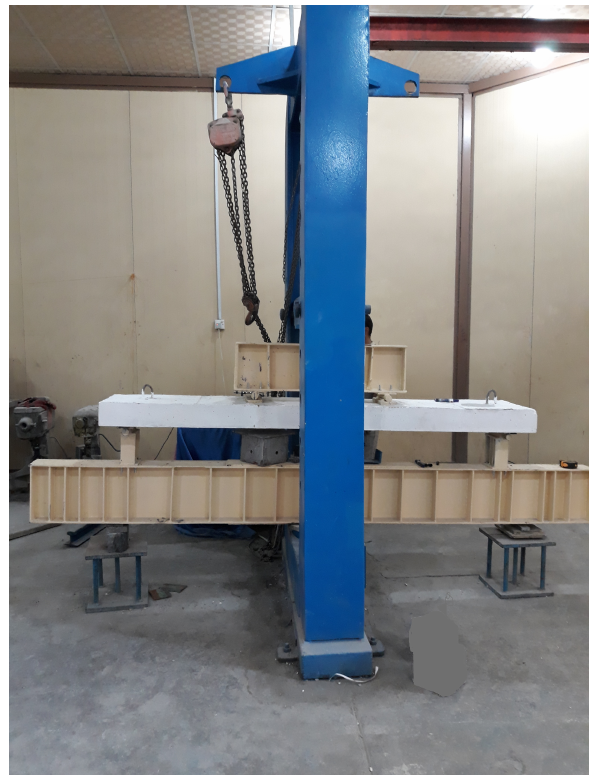
Figure 10: Flexure test machine.